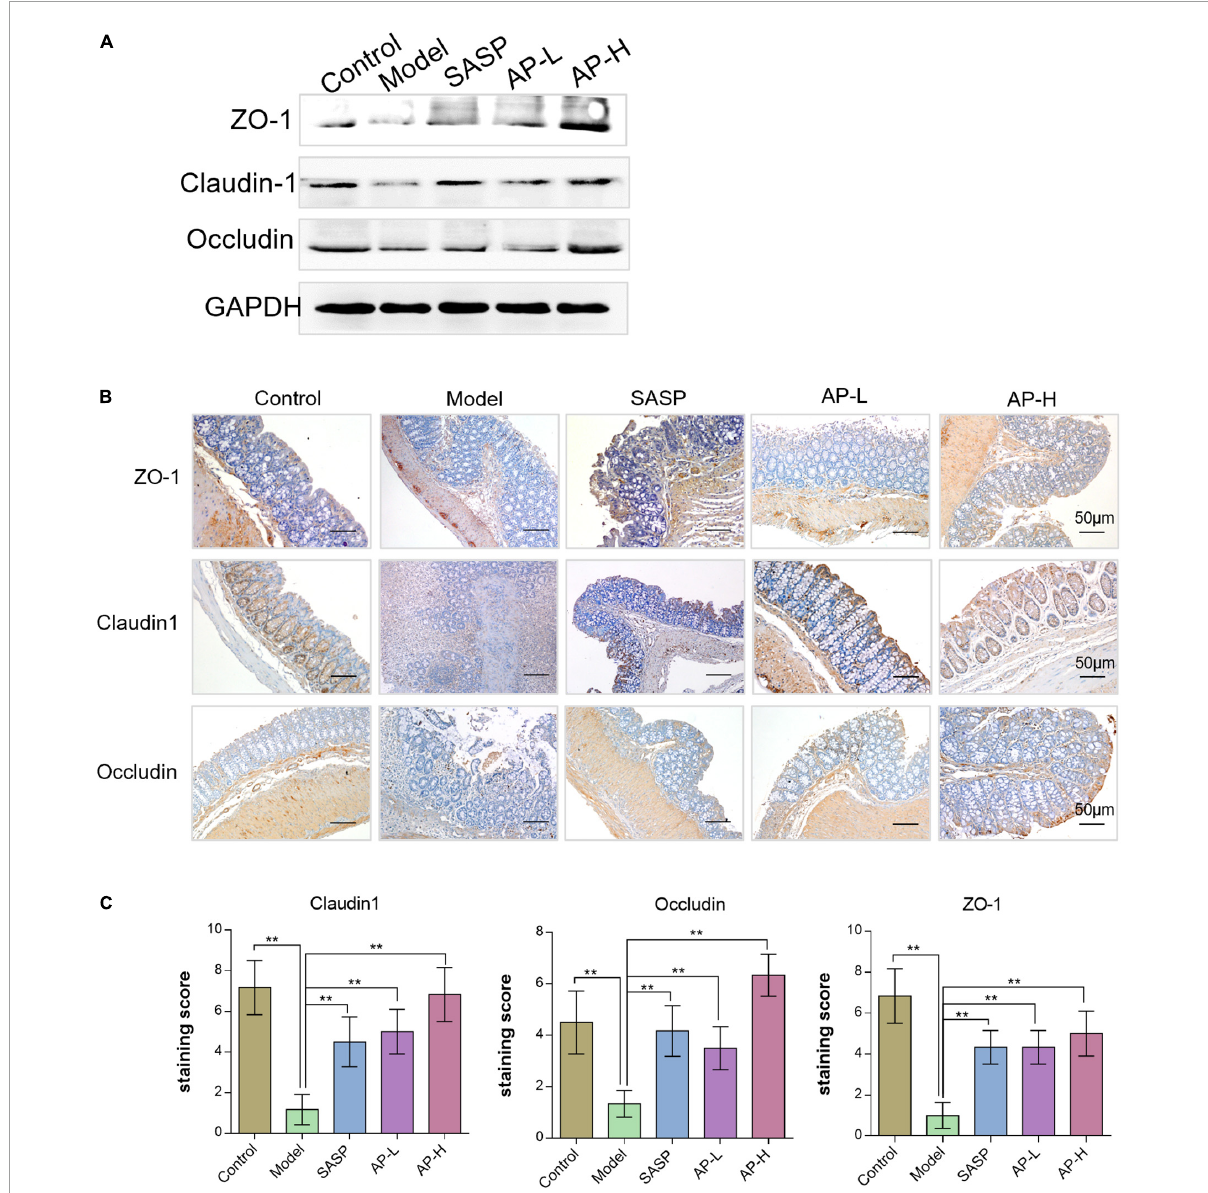
FIGURE4 Effects of apigenin on gut barrier integrity in DSS-induced colitis mice. (A) Western blot analysis detecting ZO-1, claudin-1, and occludin expressions of colon tissues in each group. (B) ZO-1, claudin-1, and occludin expression levels in the colon tissues analyzed through IHC staining. (C) IHC staining index of ZO-1, claudin-1, and occludin in colon tissues. ** P <